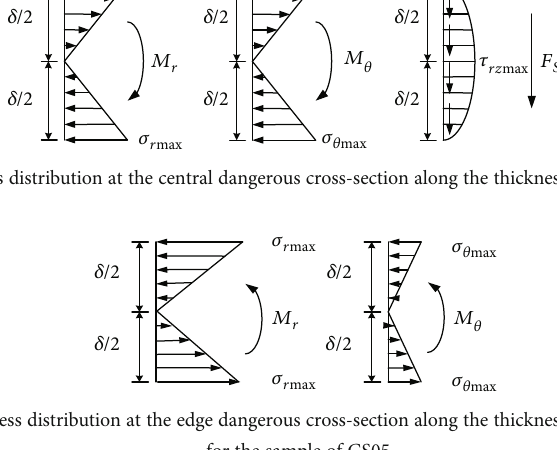
Figure 11: Stress distribution at the dangerous Table 4: The location and stresses of the dangerous points in the thin disc rock samples. Samples